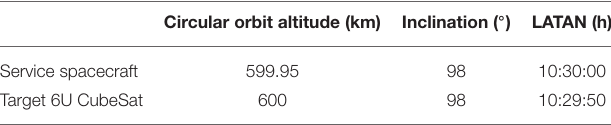
TABLE 2 | Orbital properties of the service spacecraft and the target 16U CubeSat for the demonstration mission. Circular orbit altitude (km) Inclination ( ◦ ) LATAN